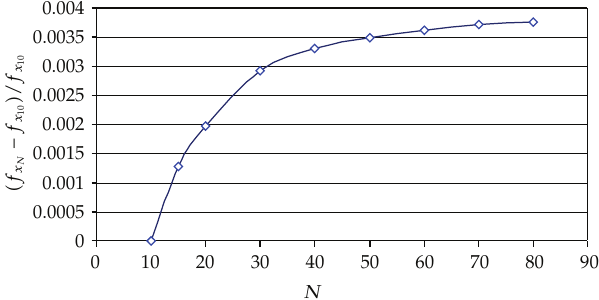
− f x 10 /f x 10 versus N element N